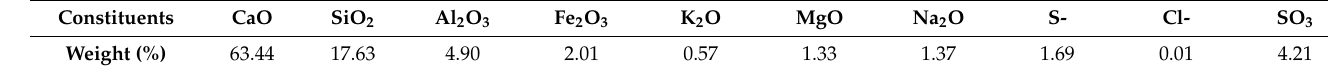
Table 1. Ghori cement chemical composition.